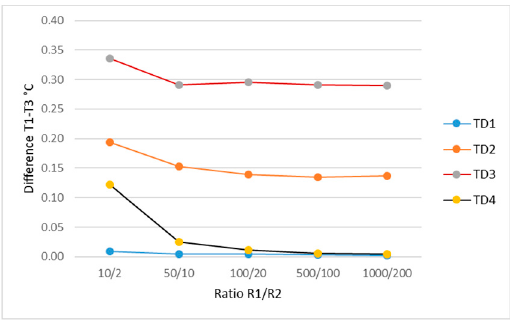
Figure 6. Influence of thermal channels materials’ thermal conductivity on the material temperature at the boundary between the tissue surface and the transducer pad.